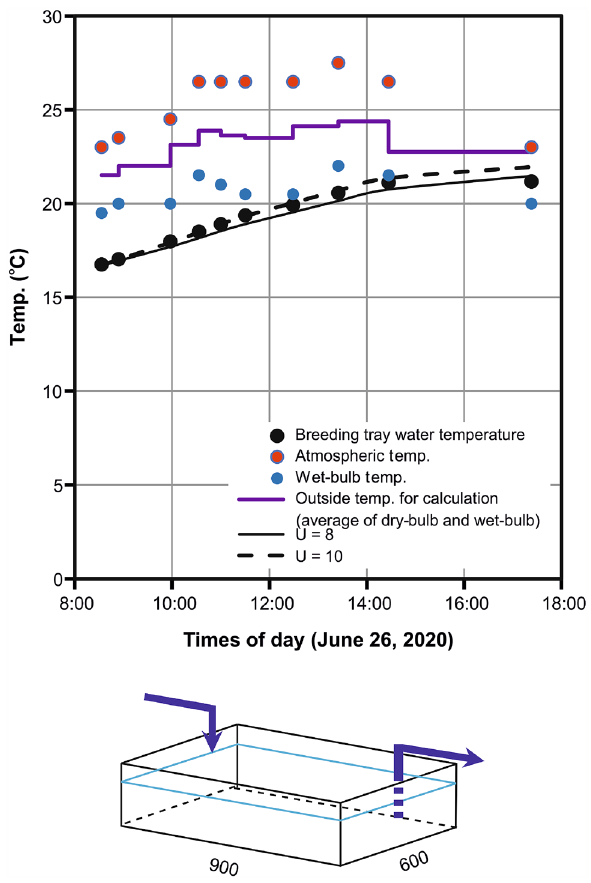
Fig. 4 Experiment with the firefly breading device. Unit of U is kcal/ m 2 h °C